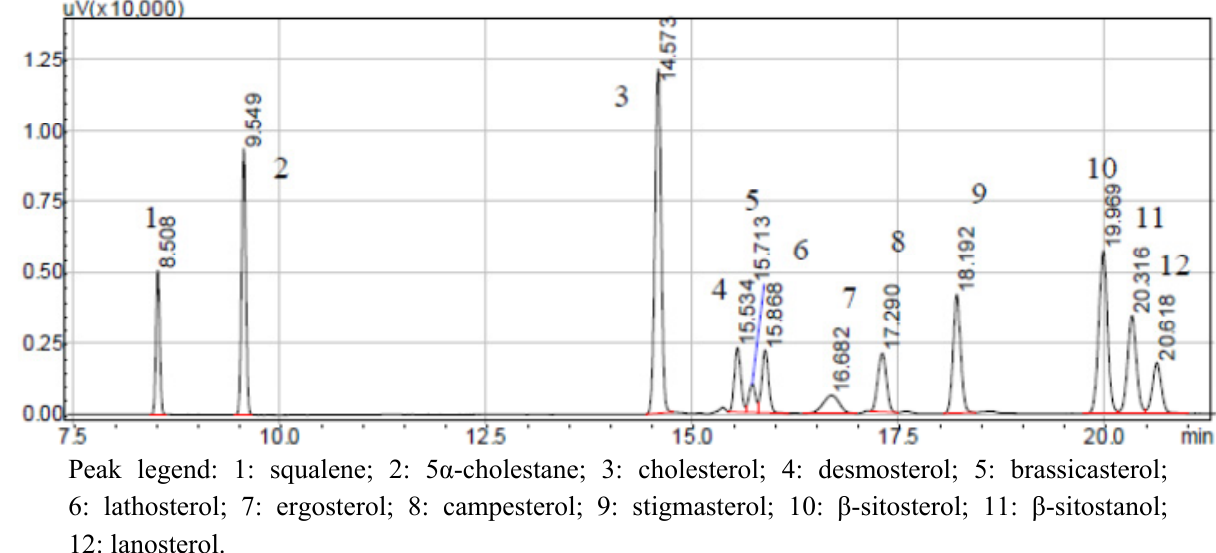
Figure 2. LC chromatograph of the sterol standard